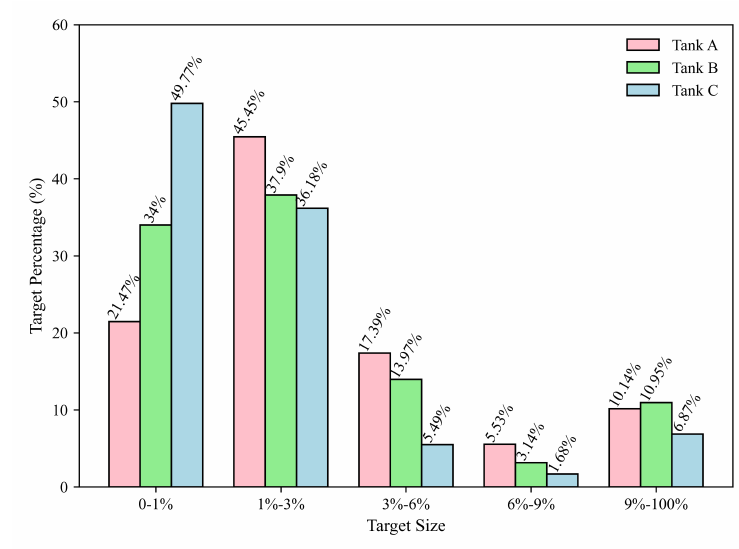
Figure 3. Object distribution